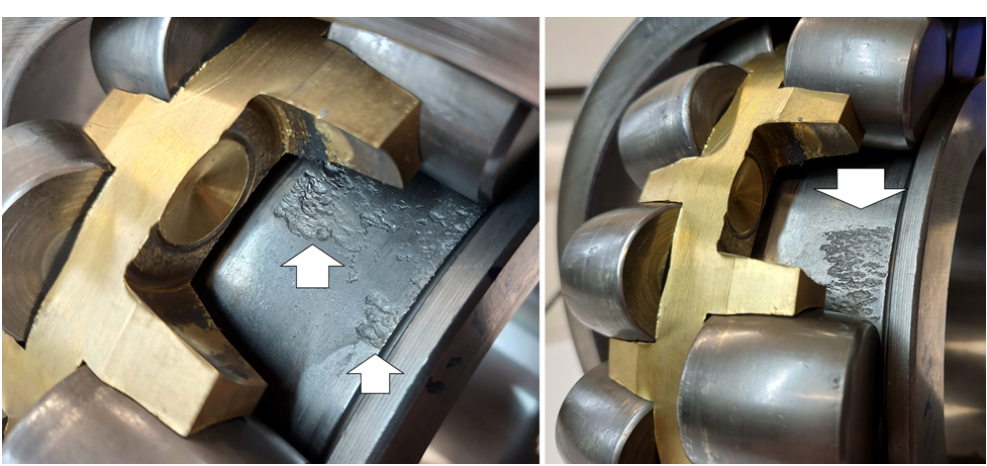
Figure 18. Picture of damaged inner